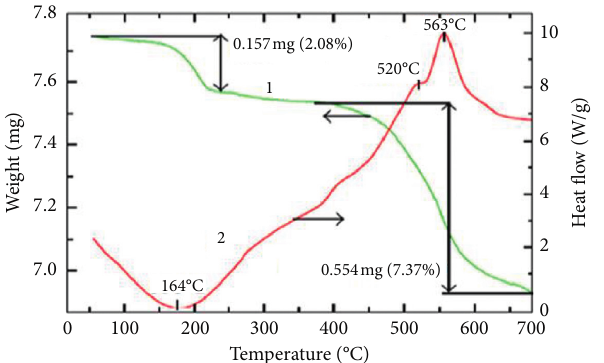
Figure 22: DSC-TGA plot of MoS